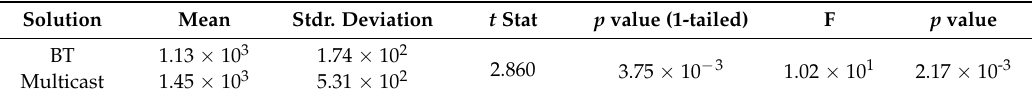
Table 3. Results of Student’s t test and Levene’s test carried out to evaluate the difference of means and variances between the data obtained from BT and multicast solutions.